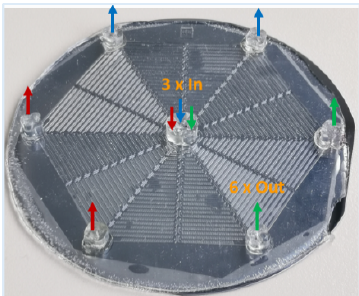
Figure 3. Picture of the final microreactor produced according to our method. The inlets (in the center) and outlets (at the edge) of the reactor are highlighted in color.